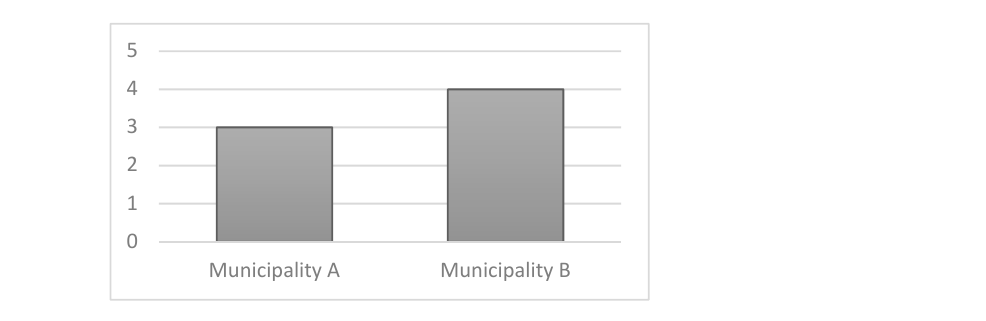
Figure 2. Degree of knowledge about the risk management strategies in Municipalities A and B.